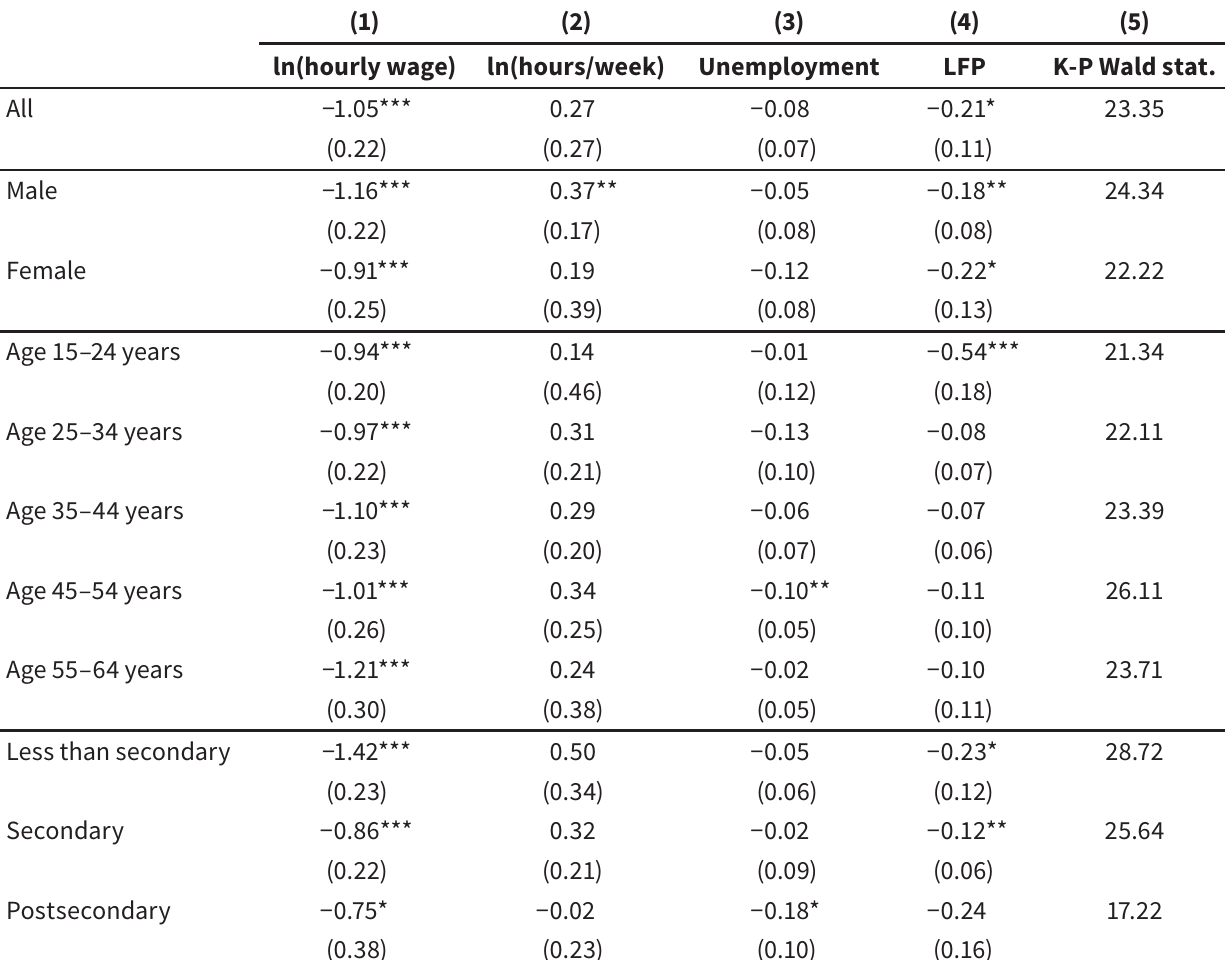
Table 2 2SLS estimates by demographic